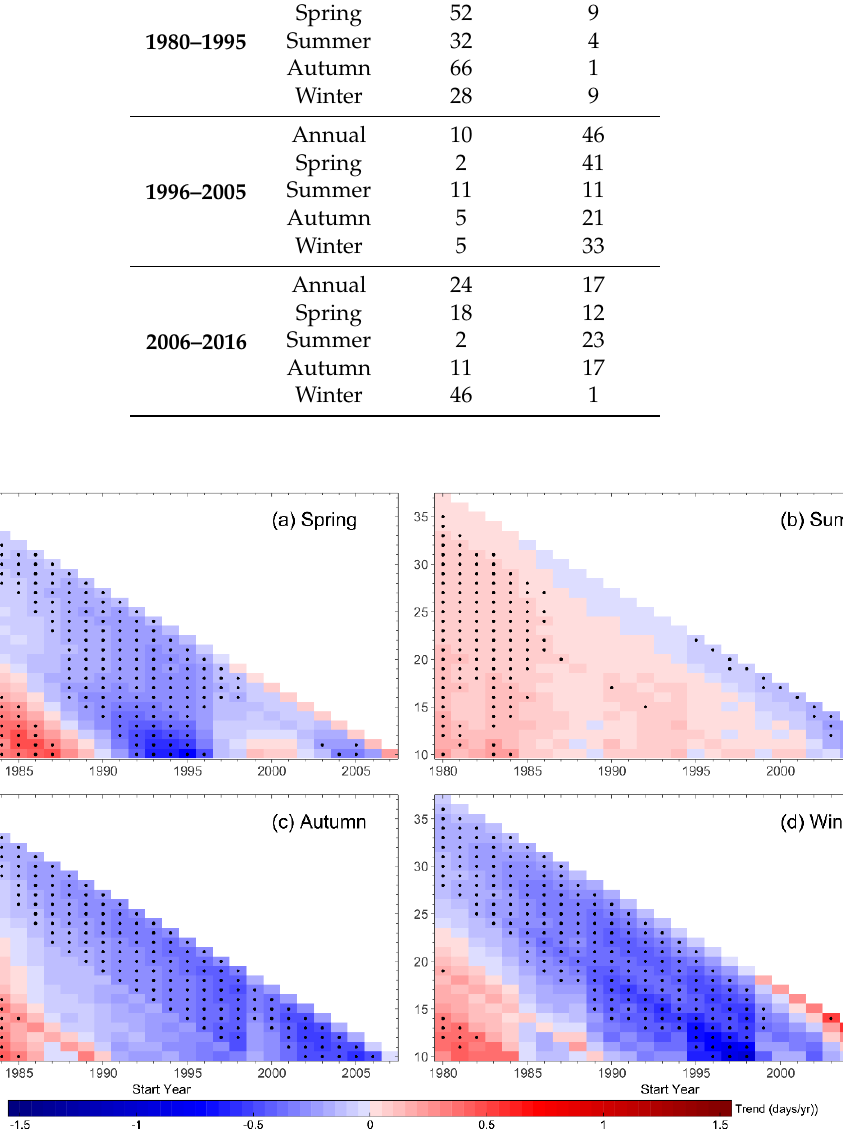
Figure 9. Same as Figure 8b, but for seasonal.